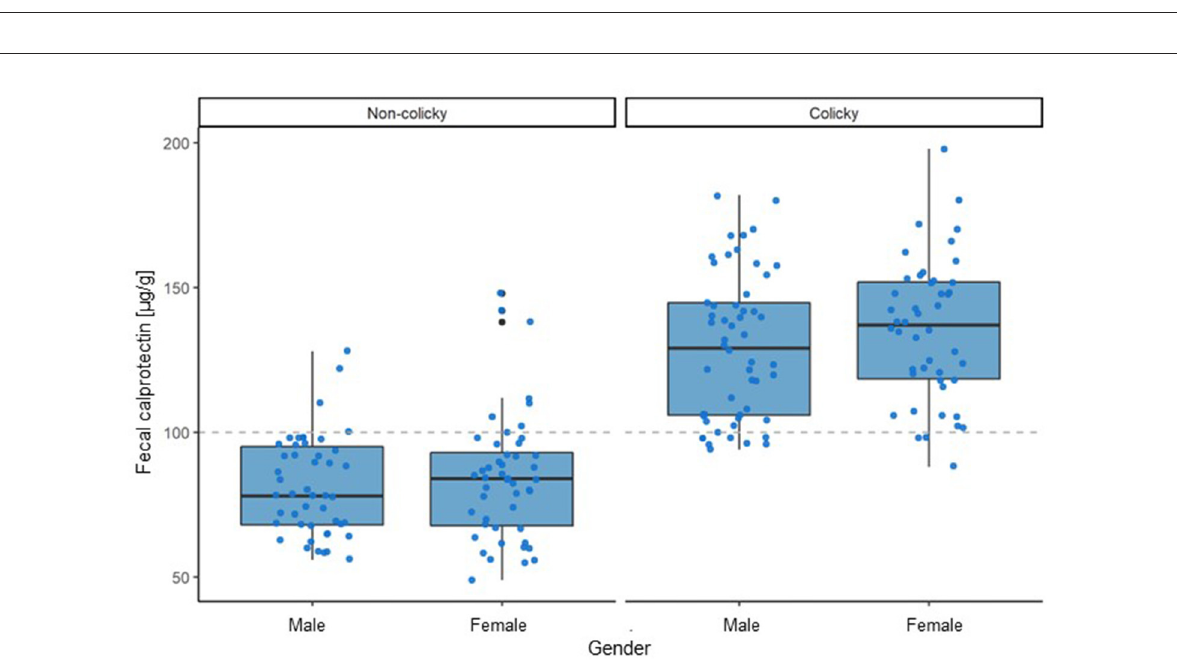
FIGURE2 Influence of gender on fecal calprotectin levels in colicky and non-colicky infants.